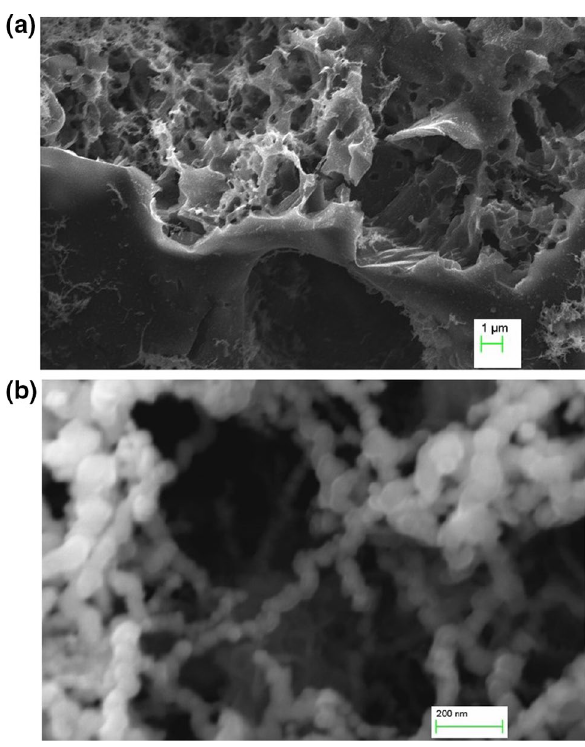
Fig. 1 a SEM Image of AC, b SEM Image of AC/NZVI nanoparticle